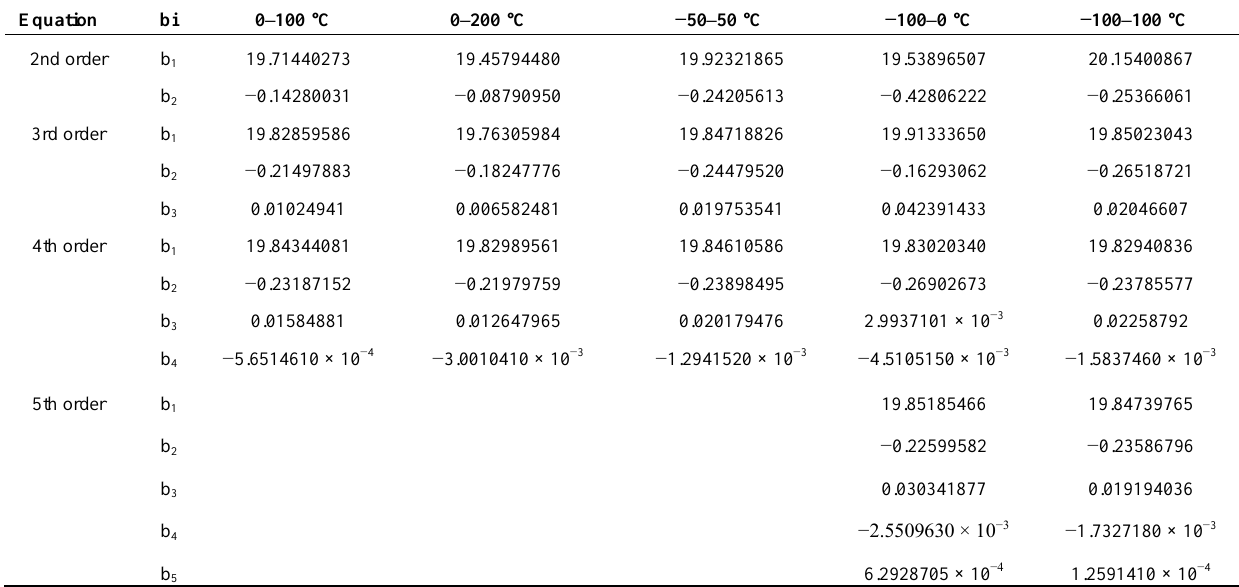
Table 4. Estimated parameters for several polynomial equations for J-type thermocouples by temperature